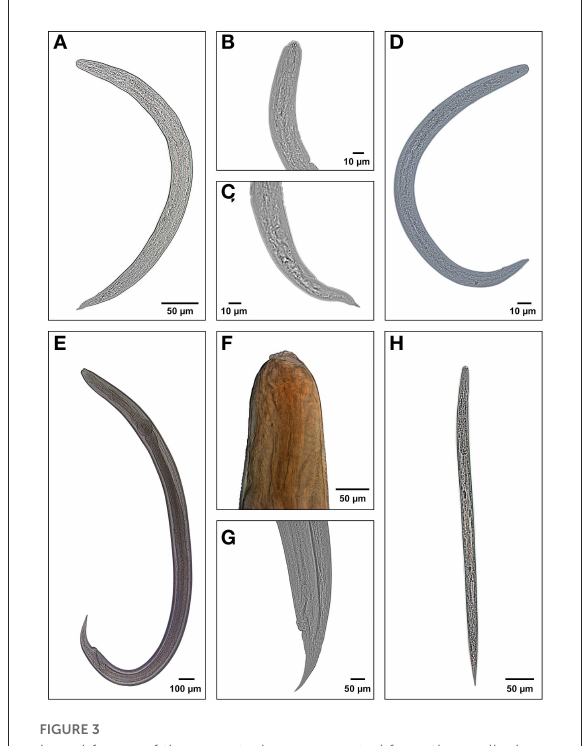
FIGURE3 Larval forms of the nematodes recuperated from the mollusks examined at the LRNEM between 2008 and 2021: (A) whole L3 larva of Angiostrongylus cantonensis ; (B) anterior extremity of Aelurostrongylus abstrusus ; (C) posterior extremity of body; (D) whole L3 larva of Aelurostrongylus abstrusus ; (E) whole larva of Cruzia tentaculata ; (F) anterior extremity of C. tentaculata , showing the excretory pore; (G) posterior extremity of C. tentaculata , and (H) free-living nematode rabditiform.